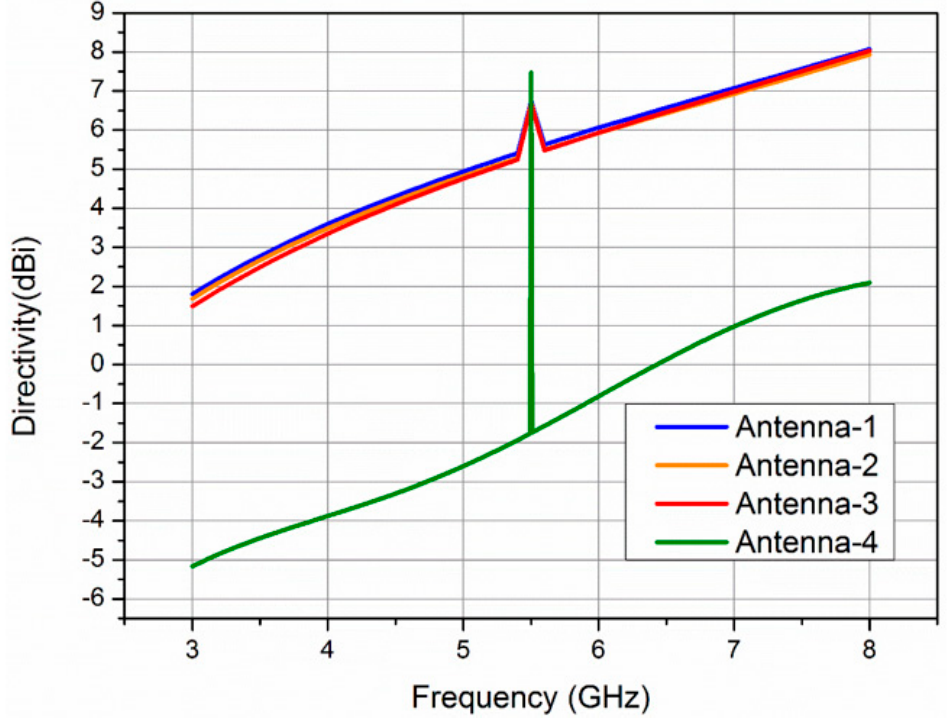
( d ) Figure 8. ( a – d ) Simulated radiation patterns at 5.3 GHz.